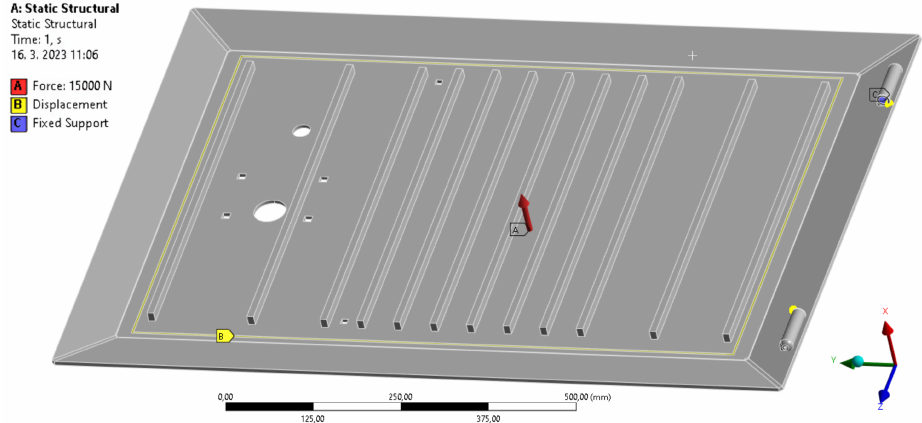
Figure 14. Boundary conditions of the hatch from the bottom